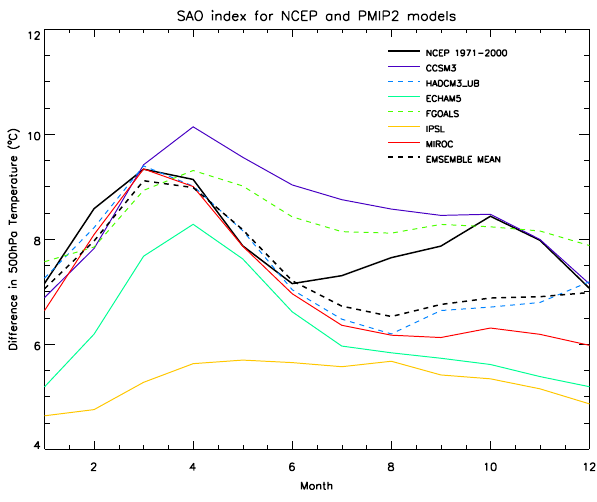
Fig. 2. The SAO index (500hPa 1T ) for NCEP data and all of the available and stable (see Braconnot et al., 2007) models from PMIP2 control run ( ◦ C). Refer to Table 1 for more details on each model.